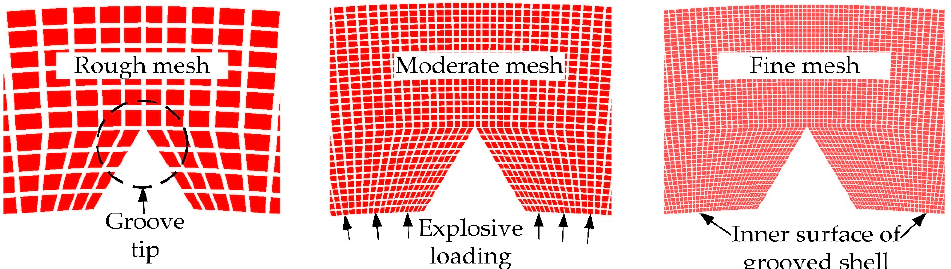
Figure 5. Detailed view of cylindrical shells with different mesh resolutions. Mesh densities at groove tips were increased for stress concentration analysis.